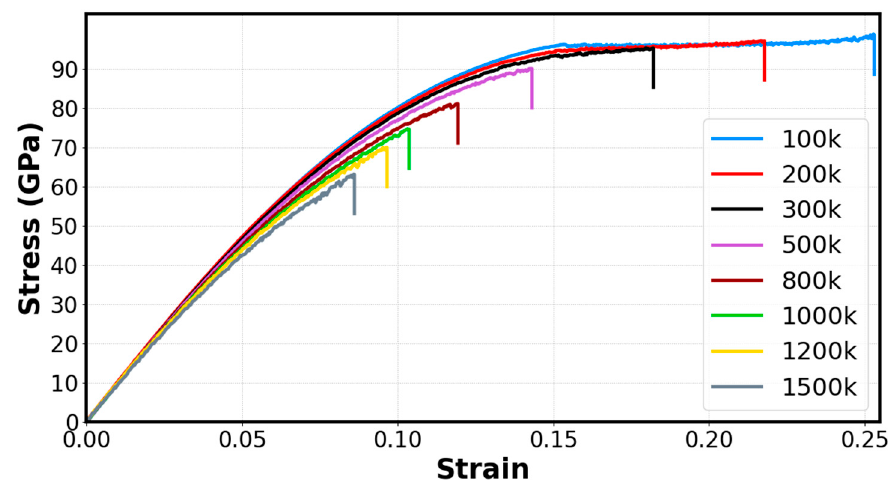
Figure 7. The stress–strain relationships of defective SLGSs at eight examined temperatures. The tensile simulations were carried out under the following conditions: The strain rate was 10 9 s − 1 . The pressure was 0.0001 GPa (1 atm). The model I loading was applied along the x axis (armchair direction). The system size was 4 × 4 (or 20.7 nm × 20.5 nm with 16,128 lattice sites). All the systems had the pre-crack in the shape of an isosceles right triangle.